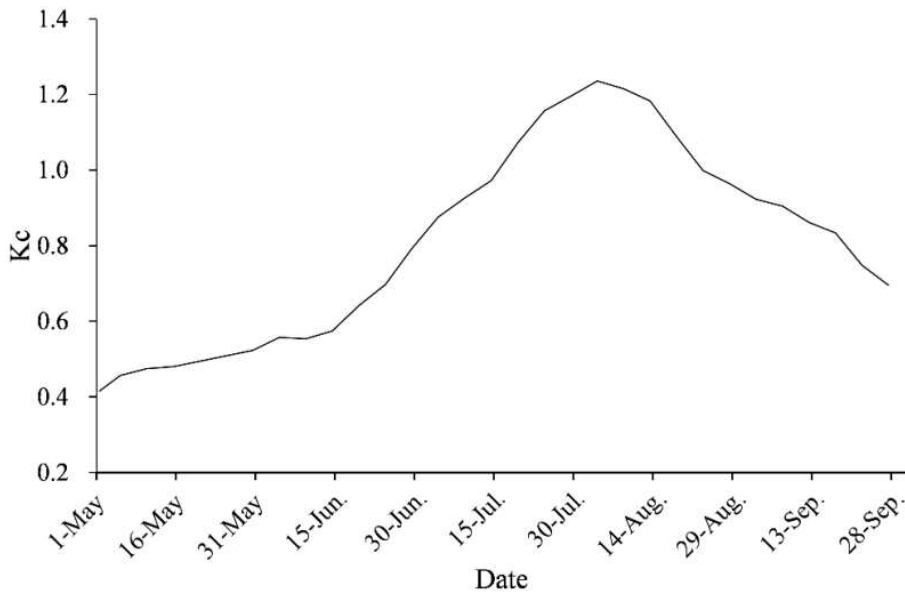
Figure 2. Crop coefficients of maize in the Xiliao River Plain.